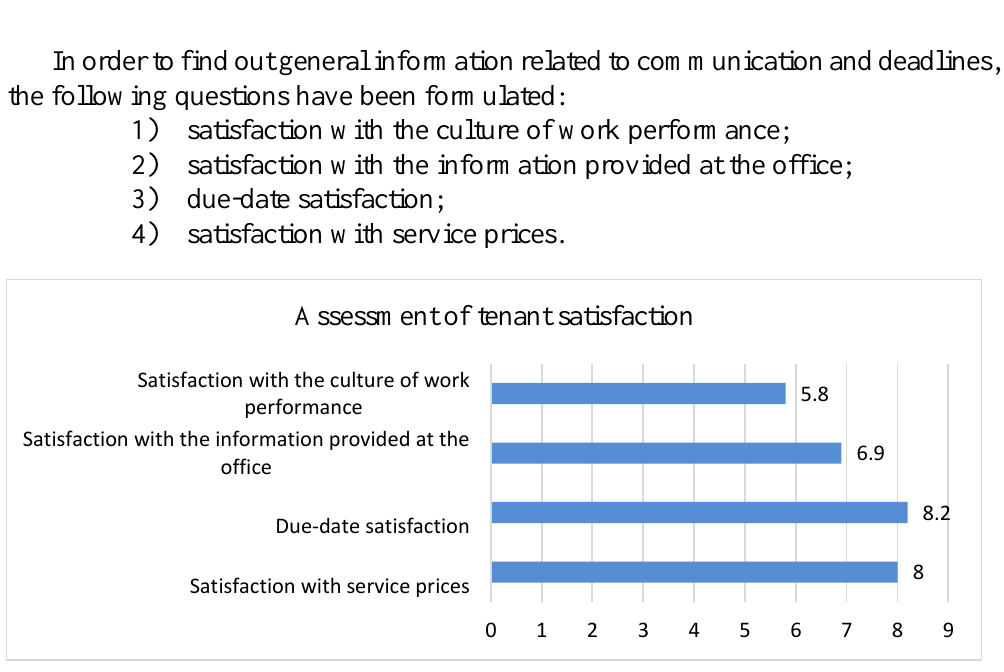
Fig. 6. Assessment of tenant satisfaction based on a general